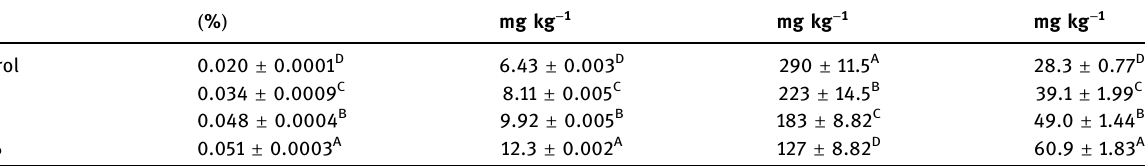
Mean ± standard error of three replicates having di ff erent letters in a column show a signi fi cant di ff erence at p ≤ 0.05 ( Tukey ’ s test ) .